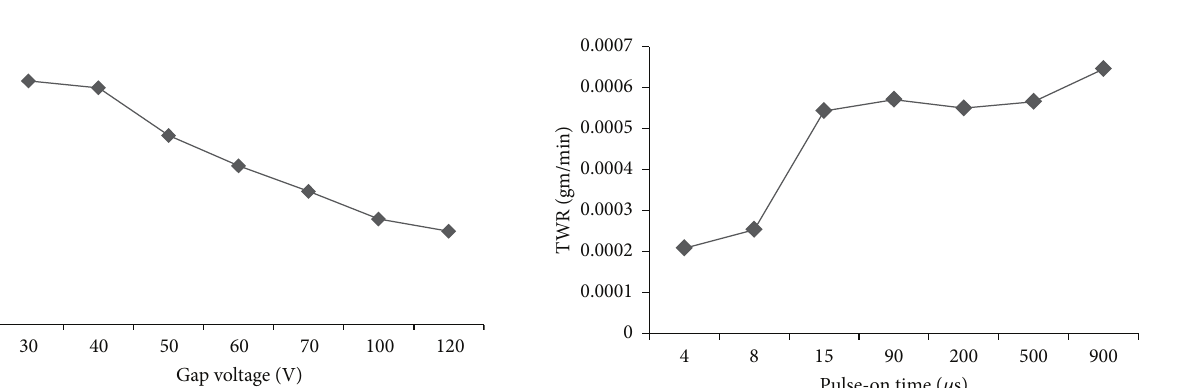
Figure 14: Influence of pulse-on time on TWR at constant current 9 Amp, gap voltage 60V, and pulse-off time 90 𝜇 s.